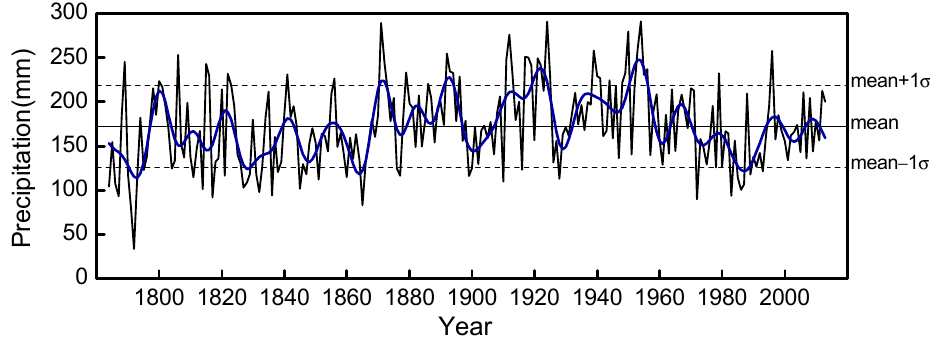
Figure 6. Reconstructed June–July precipitation (black line) during 1784–2013 AD. The blue line is the 11-yr moving average.